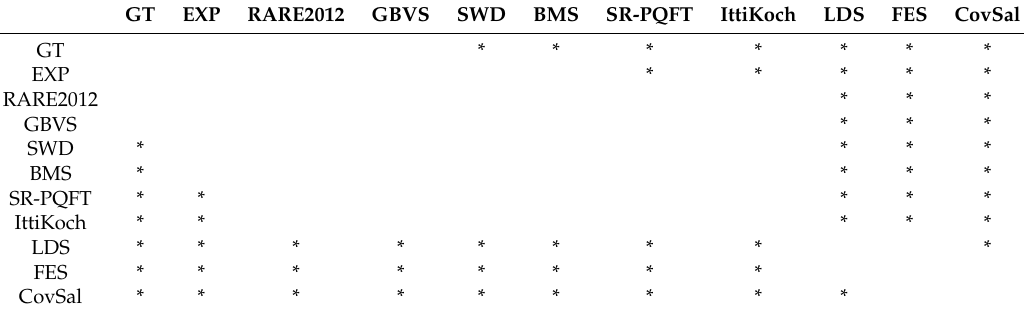
Table 4. Significance of differences of calibration errors between various saliency models taking MCF DIR and removalPercent = 20. The asterisk (*) denotes that according to the t -Student test for either x or y axis the difference was significant ( p <